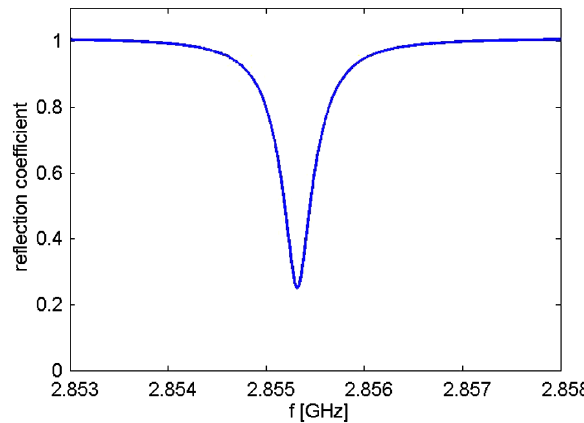
FIG. 10. Reflection coefficient at the input port (measured in air at 65% relative humidity and 20 °C).